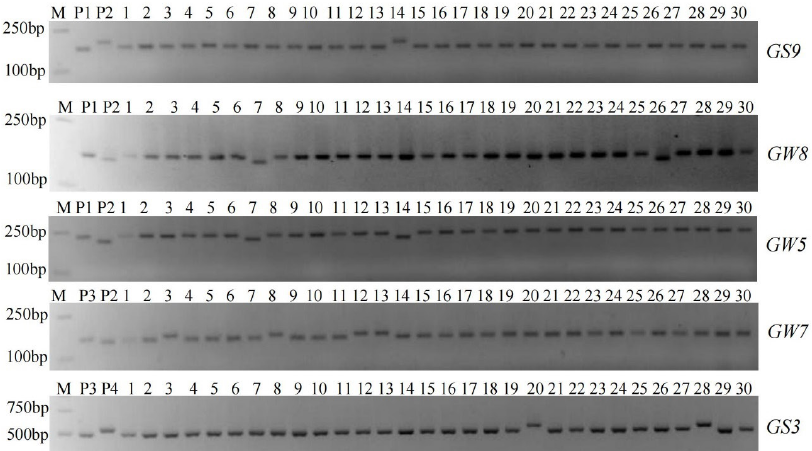
Fig. 4: Genotype of Grain Shape Genes. Electrophoresis pattern of test genotypes including resistant/tolerant check (P1 & P3) and susceptible check (P2 & P4) using grain shape genes ( GW7 , GS3 , GS9 , GW5 and GW8 ) linked markers. M: marker (100-2000 bp); P1: Yuenongsimiao; P2: Lijiangxintuanheigu (LTH); P3: Xiangyaxiangzhan, P4: Yuexiangzhan.